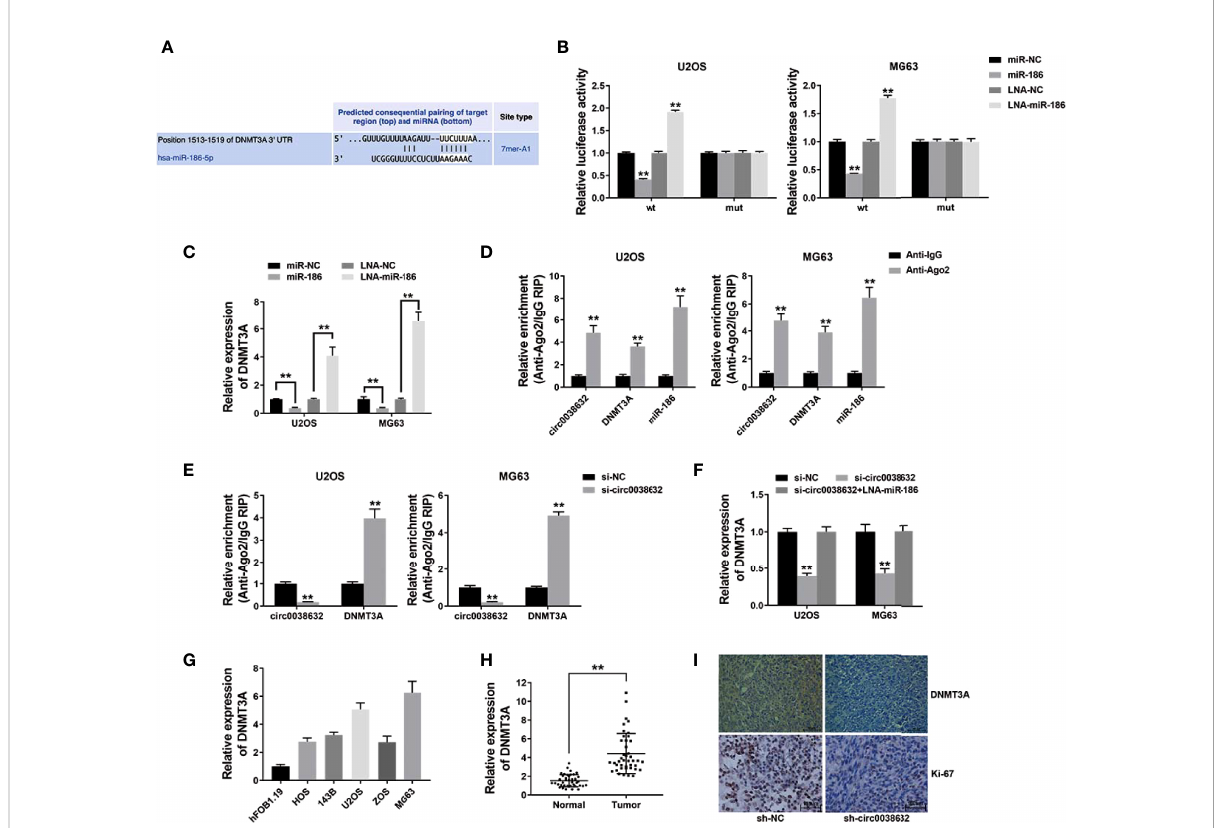
FIGURE 4 circ0038632 functions as a ceRNA by mediating DNMT3A in osteosarcoma. (A) Potential binding sites from 3 ′ -UTR of DNMT3A with miR-186. (B) Relative luciferase activities of different co-transfected groups. (C) DNMT3A expression was tested after transfection by qRT-PCR. (D) The degree of circ0038632, DNMT3A, and miR-186 enrichment to Ago2 was examined by RIP assay. (E) The enrichment on Ago2 after transfection was tested. (F) DNMT3A mRNA expression was examined. (G) DNMT3A mRNA expression in osteosarcoma cells was tested. (H) DNMT3A mRNA expression in osteosarcoma tissues and its control were detected. (I) IHC staining of DNMT3A and Ki-67 were shown. ** P <